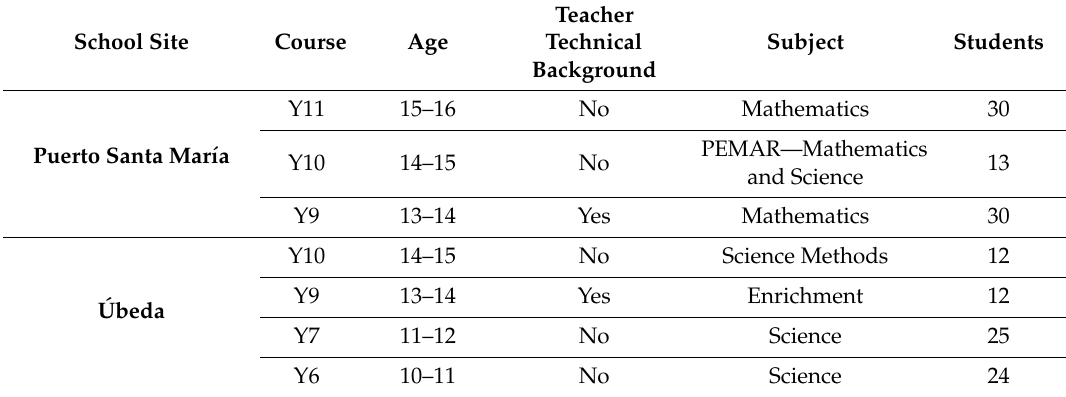
Table 1. First cycle